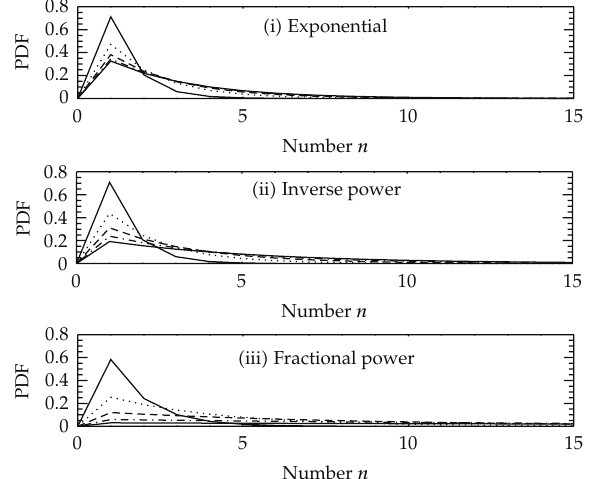
Figure 5: Time-dependence of p (cid:3) n,t (cid:4) in (cid:3) 3.21 (cid:4) for three relaxation functions for κ (cid:3) t (cid:4) in Table 2: (cid:3) i (cid:4) an exponential function, (cid:3) ii (cid:4) an inverse power function, (cid:3) iii (cid:4) a fractional power function; the values of parameters are α (cid:7) 1, κ (cid:7) 1, and γ (cid:7) 0 . 85. The pdf profiles are depicted for t (cid:7) 0 . 4 (cid:3) solid line (cid:4) , t (cid:7) 1 . 2 (cid:3) dotted line (cid:4) , t (cid:7) 2 . 0 (cid:3) dashed line (cid:4) , t (cid:7) 2 . 8 (cid:3) dash-dotted line (cid:4) , and t (cid:7) 3 . 6 (cid:3) dash-dotted line (cid:4)